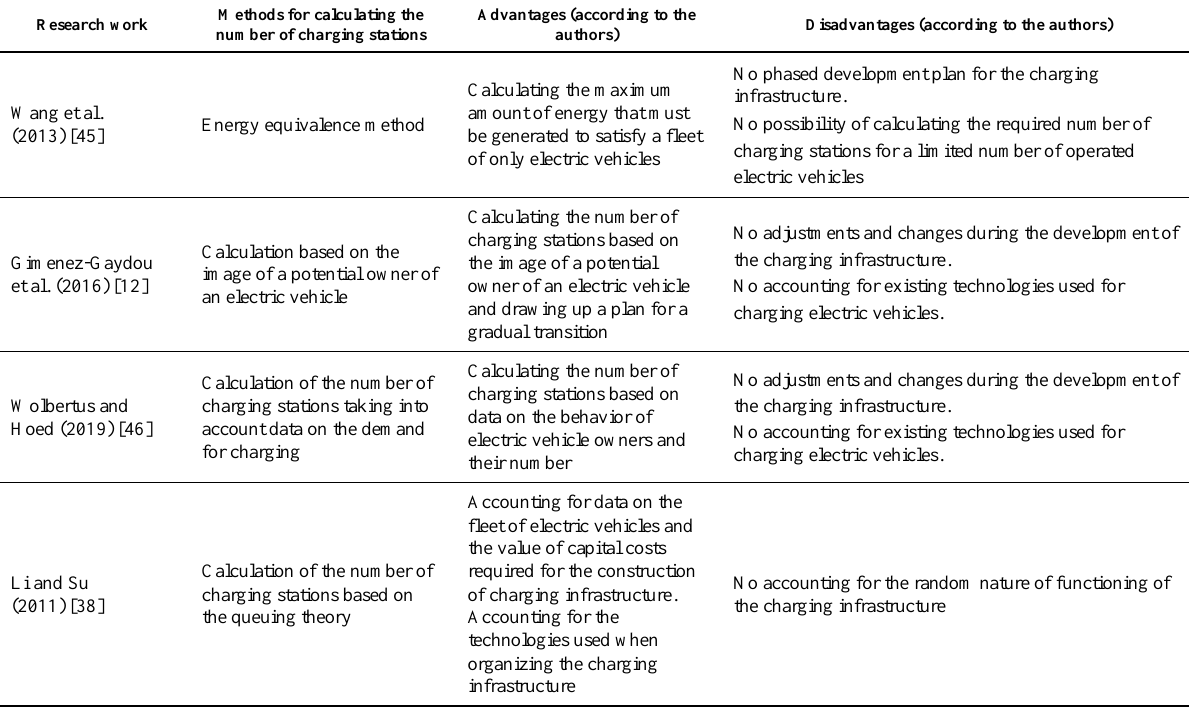
Table 2. Analysis of publications on the location and number of charging stations for electric vehicles in